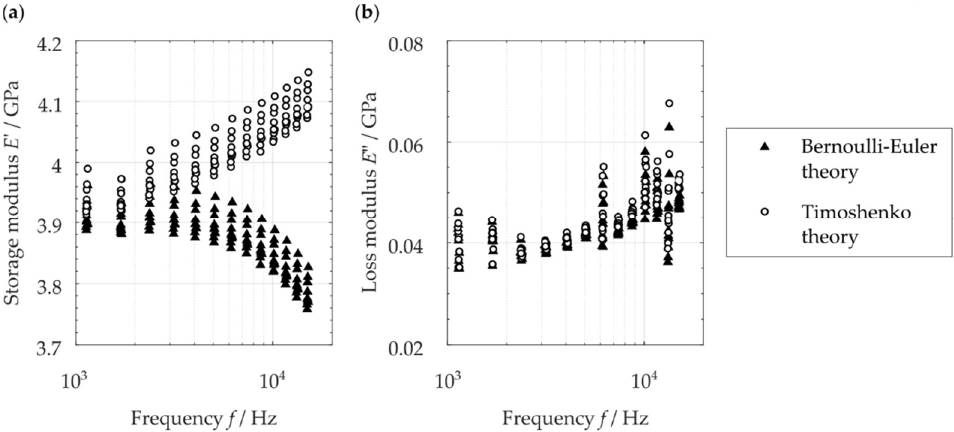
Figure 8. Resulting mechanical properties of PEEK (tightening torque 𝑀 t = 1.1 Nm, voltage amplitude of the actuator 𝑈(cid:3553) e = 11 V): ( a ) storage modulus 𝐸′ , ( b ) loss modulus 𝐸″ .